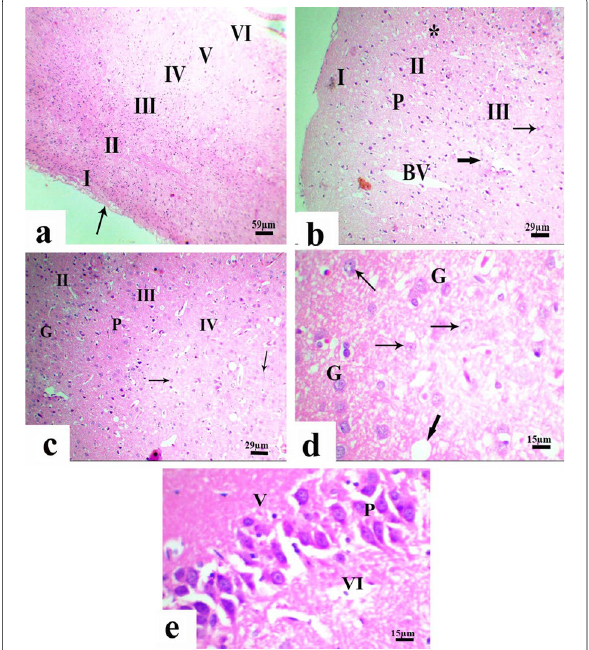
Fig. 1 photomicrographs of sections of the cerebral cortex obtained from the control rats showing a : cerebral cortex covered by pia matter (arrow) and the gray matter with its six layers; the outer molecular layer (I), the external granular layer (II), the external pyramidal layer (III), the inner granular layer (IV), and the inner pyramidal (V) and polymorphic layers (VI). b : layer (I), layer (II) contains rounded granule cells island (*), small pyramidal cells (P), and layer (III) contained medium sized pyramidal cells (thin arrow), some granule cell (thick arrow) and blood vessel (BV). c : layer (II) with rounded granule cell (G), layer (III) with triangular cell shaped pyramidal cells (P), layer (IV) contains granule cells with open face nuclei (arrows). d : internal granular layer with large rounded granule cells (G) had open face nuclei (thin arrows) and the blood vessel (thick arrow) also seen. e : showing layer (V) with large pyramidal cells (P) and layer (VI) contains various sized neurons